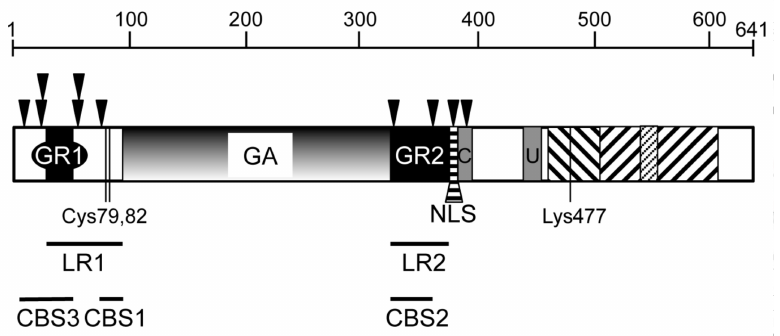
Figure 1. Diagramatic linear representation of the domains of Epstein-Barr virus (EBV) nuclear antigen-1 (EBNA1). The 641 amino acid sequence of the B95-8 strain of EBV EBNA1 is depicted to approximate residue scale (as indicated). GR (black box): Gly/Arg rich domains (GR1:aa33–35, GR2: aa327–377); GA (gradient shading): Gly/Ala repeat (aa90–324); black triangles: predicted phosphorylation sites (Thr8, Thr 20, Ser21, Ser60, Ser62, Ser78, Ser332 Ser365, Ser383, Ser393); NLS (horizontal cross hatched): nuclear localisation signal (378–386); grey boxes (C and U): casein kinase 2 (CK2) and ubiquitin-specific protease 7 (USP7) core binding domains (aa383–395, 436–351 respectively); diagonal cross-hatching: DNA binding and dimerization domain (flanking and core: aa459–503 and 504–607 respectively), with proline-rich loop indicated by fine hatching (aa 538–555); Cys79 and Cys82: key cysteine residues in EBNA1 multimerisation; Lys477: predicted ubiquitination site; LR1 and LR2: linking regions 1 and 2 (aa33–89, aa325–379 respectively); CBS1, 2 and 3: chromatin binding sites 1, 2 and 3 (aa72–84, aa328–365 and aa8–54